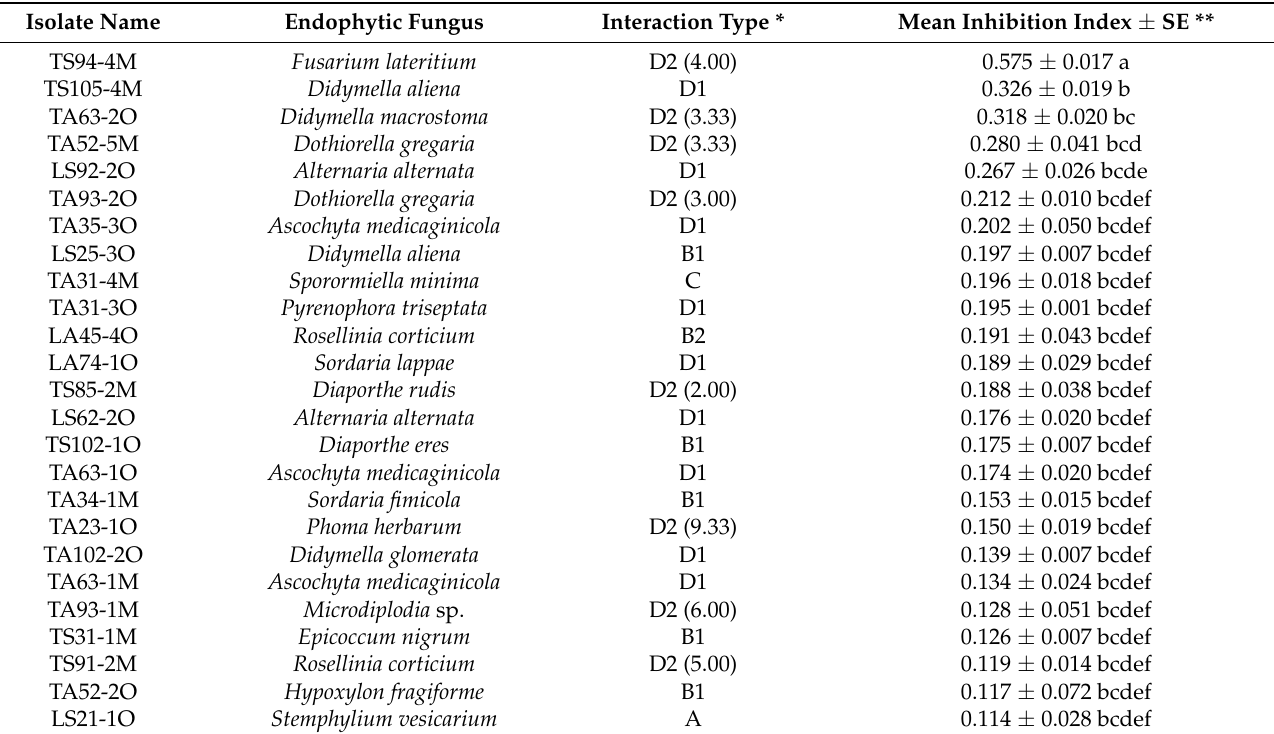
Table 3. Inhibitory effect of endophytic fungi on the radial growth of Hymenoscyphus fraxineus in a dual culture